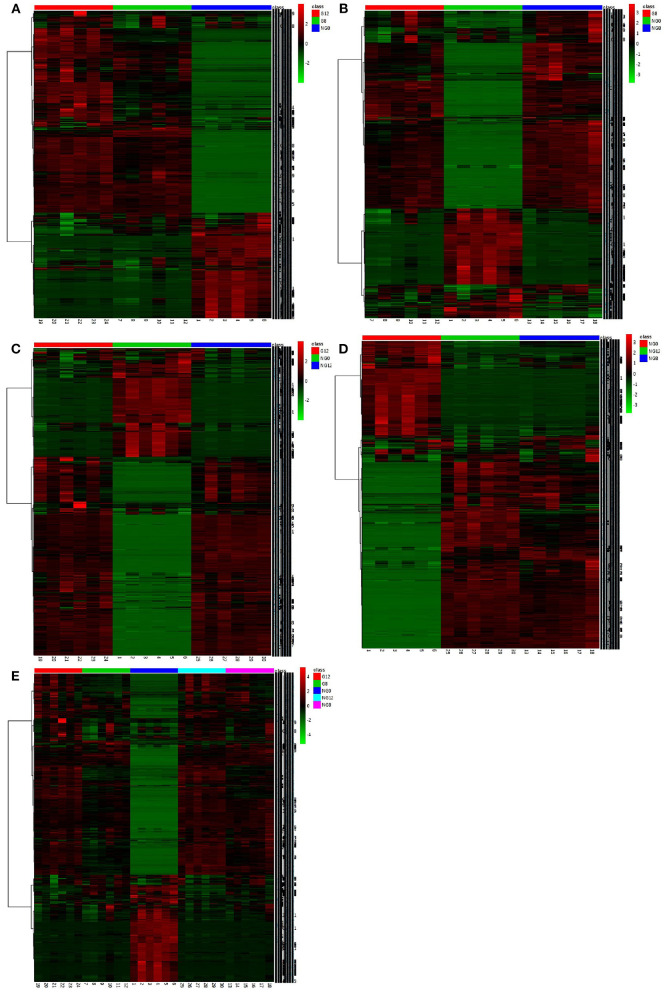
The cluster maps of samples. (A) NG0-G8-G12; (B) NG0-G8-NG8; (C) NG0-G12-NG12; (D) NG0-NG8-NG12; (E) G8-G12-NG0-NG8-NG12. The abscissa represents the sample number, and the ordinate represents the molecular weight of each metabolite.